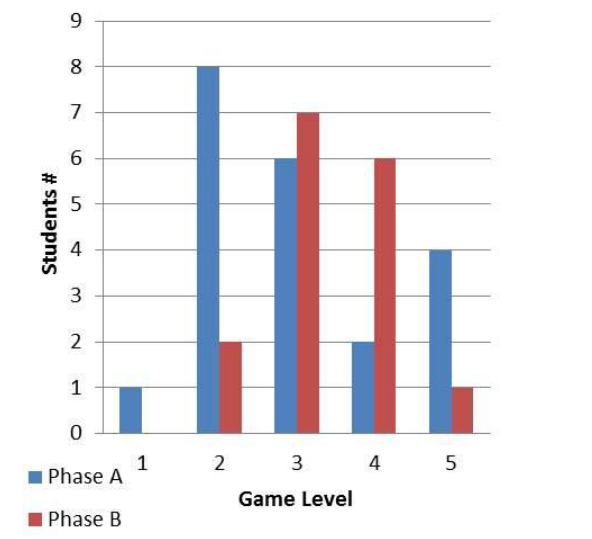
Table 3: Flow components in 2 phases of the game “Couch Potatoes Defence ” design process